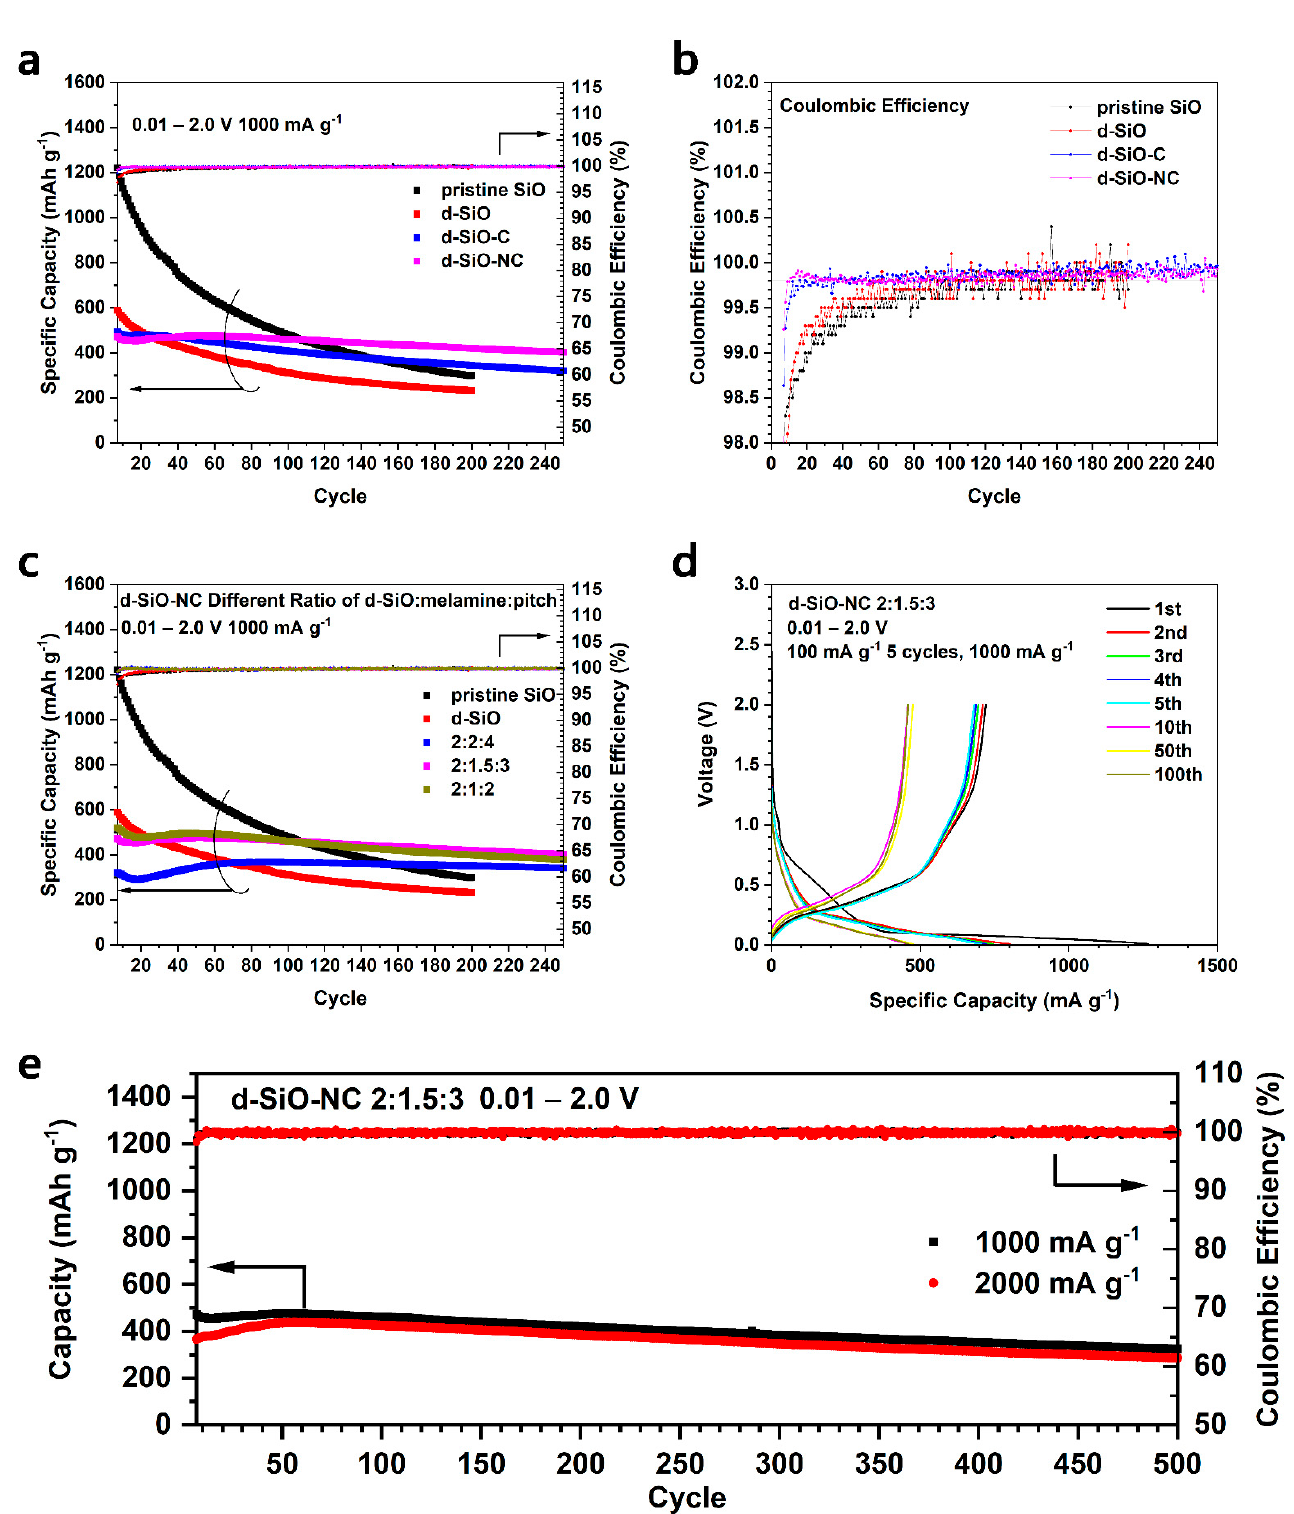
Figure 5. Cycling performance of half cells fabricated by pristine SiO, d-SiO, d-SiO-C (2:4.5) and d-SiO-NC (2:1.5:3) ( a ) and their Coulombic efficiency ( b ). ( c ) Cycling performance of half cells fabricated by pristine SiO, d-SiO and d-SiO-NC with different ratio of raw materials. ( d ) Charge/discharge voltage profiles of d-SiO-NC (2:1.5:3) in different cycles. ( e ) Long cycling performance at different current density of d-SiO-NC